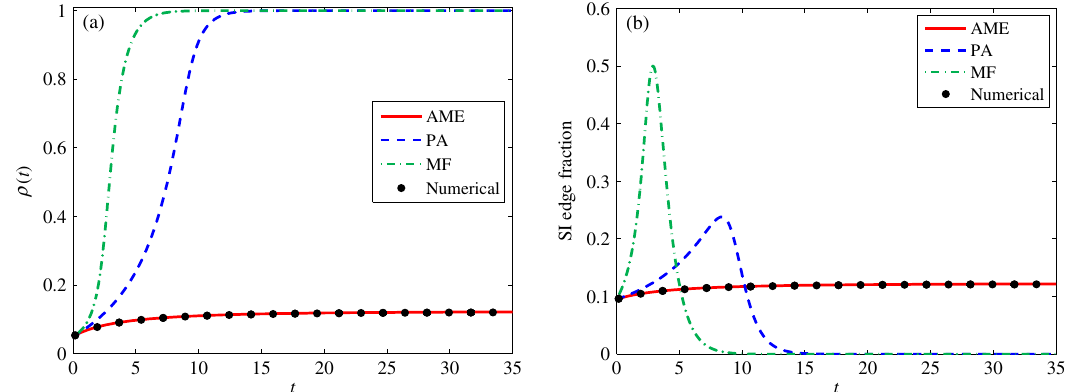
FIG. 8. Threshold model on a five-regular random graph, with all nodes having the same threshold M ¼ 2 ; the initial condition is (cid:5) ð 0 Þ ¼ 0 : 05 . The AME solution is identical to the solution of the two-dimensional system